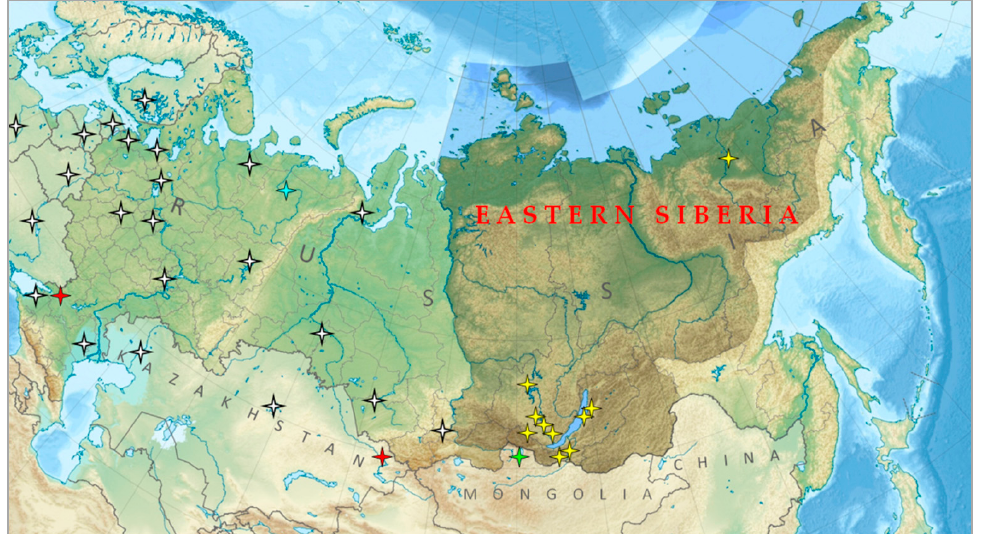
Figure 1. Location map of the study region. The territory of Eastern Siberia is highlighted by the shaded background. Asterisks indicate the places where different piscine leeches of the genus Piscicola were found: data of this study (red, yellow, green and blue marks, depending on species) and literature data on Piscicola geometra (L., 1758) distribution (colorless marks). The relief is dominated by low and middle mountains. The western part of Eastern Siberia is occupied by the taiga of the Central Siberian Plateau, the largest forest massif in Russia, which is replaced in the north by tundra lowlands, and is preplaced in the south and east by the high mountain ranges of the Eastern Sayan Mountains, the moun- tains of Transbaikalia and the Kolyma Territory. In some high mountain ranges, alpine landforms have developed in combination with modern glaciations (Orulgan, Momsky, Sunta-Khayata,